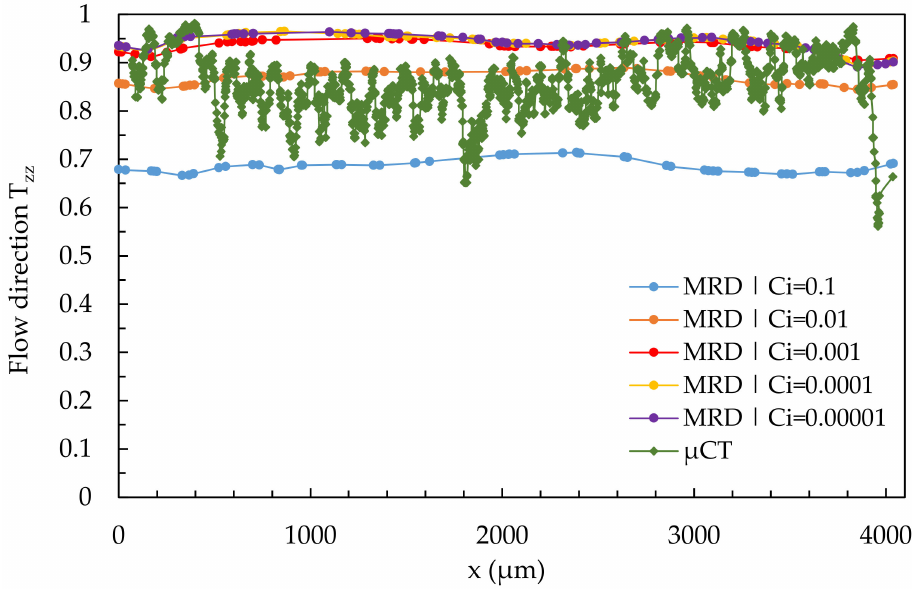
Figure 17. Quantitative results of fiber orientation in T zz -direction over the cross-section characterized by µ CT and predicted by the 3D mesh under variation of the fiber interaction coefficient C i at location 2.3.